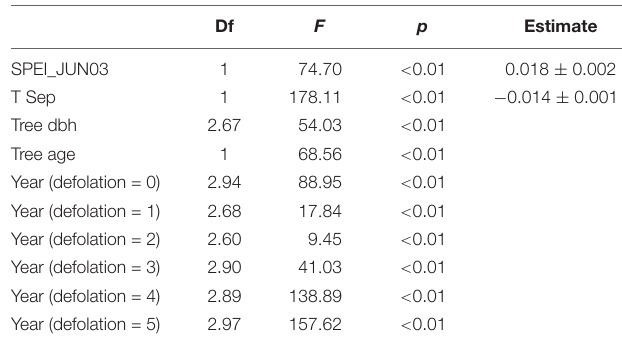
TABLE 3 | Summary of the Generalized additive mixed model selected to predict basal area increment as a function of drought (SPEI03, 3-month long June SPEI), previous September temperature (T Sep), tree diameter at breast height (dbh) and tree age at 1.3 m. Df p